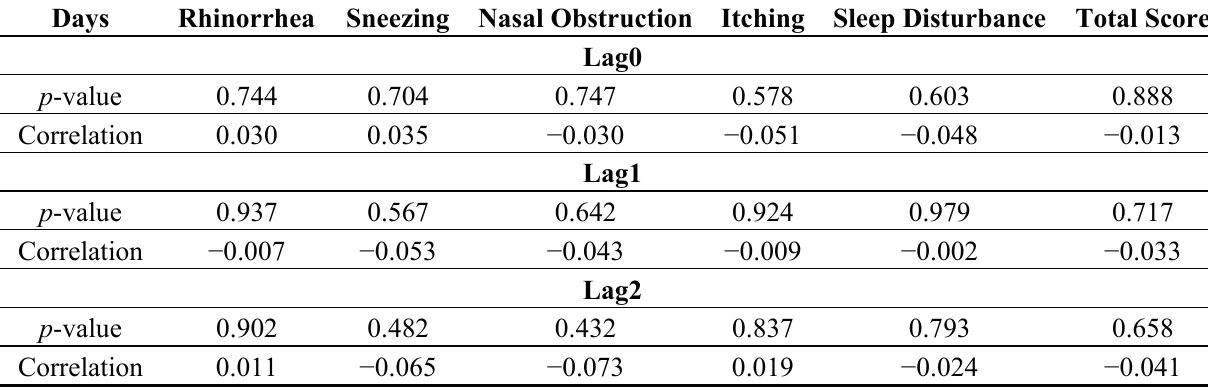
Table 7. The relationship between the most-affected days after high PM 10 concentration exposures and allergic nasal symptoms.